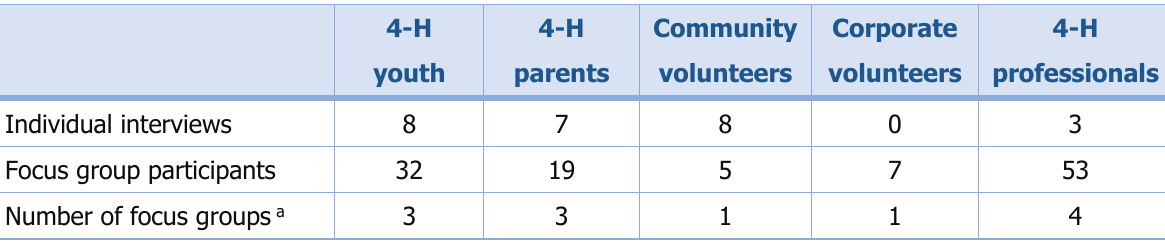
Table 1. Participants in Focus Groups and Individual